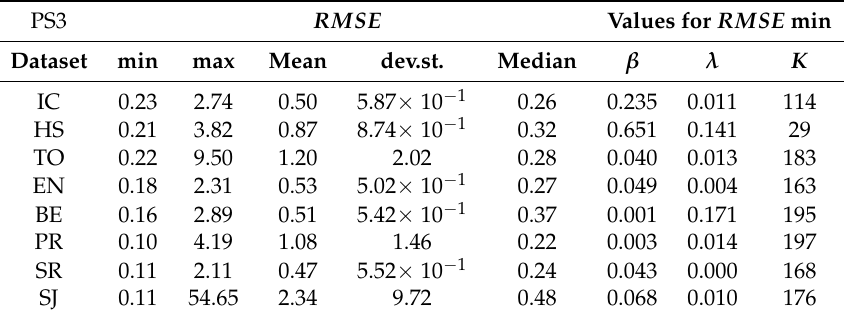
Table 5. Results for the optimization method PS3.